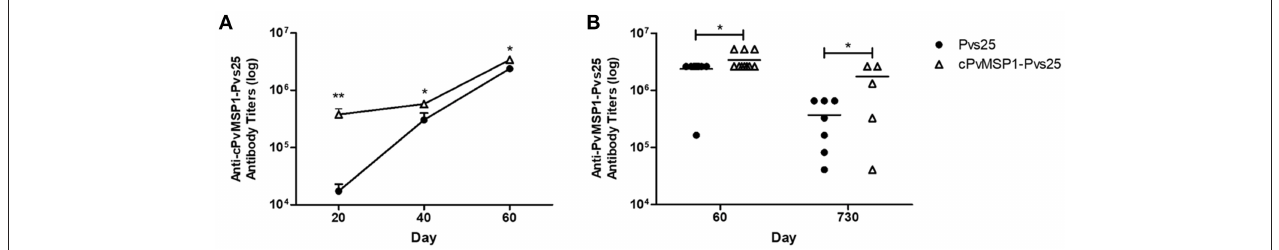
FIGURE 2 | Antibody responses to the chimeric PvMSP1-Pvs25 protein. Antibody responses against the chimeric PvMSP1-Pvs25 protein were assessed in CB6F1/J mice following immunization with either Pvs25 (closed circles) or cPvMSP1-Pvs25 (open triangles). (A) Time course of antibody responses to cPvMSP1-Pvs25 on days 20, 40, and 60 ( n = 10). (B) Comparison of antibody titers between day 60 ( n = 10) and at 2 years (730 days after the first immunization, n = 7). The titers against PvMSP1-Pvs25 are shown. Statistical analysis was conducted using Mann Whitney tests. Statistically significant differences are denoted by * p < 0.05 and ** p < 0.01.